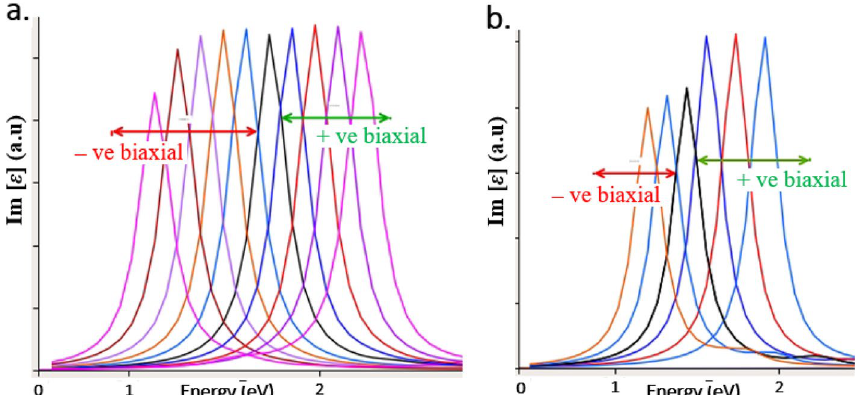
Figure 8. Biaxial strain inducement simulations using plane-wave and LCAO calculations, for C B V N defect. ( a ) + ve and −ve biaxial strain inducement simulation of C B V N defect using plane-wave calculations. ( b ) + ve and −ve biaxial strain inducement simulation of C B V N defect using LCAO calculations. Both the plane-wave and LCAO calculations exhibit similar tuning of quantum emission from C B V N defect towards lower and higher energy regions. We computed ⁓ 3.45% positive and negative biaxial strain (– 3.45% to + 3.45%). The black colour peak in both the figures ( a , b ) indicates ZPL quantum emission at 1.7 eV from C B V N defect under no external strain (zero strain) condition. For + ve biaxial strain tunability is observed upto 2.05 eV (blue-shifted) and for −ve biaxial strain tunability is observed upto 1.22 eV